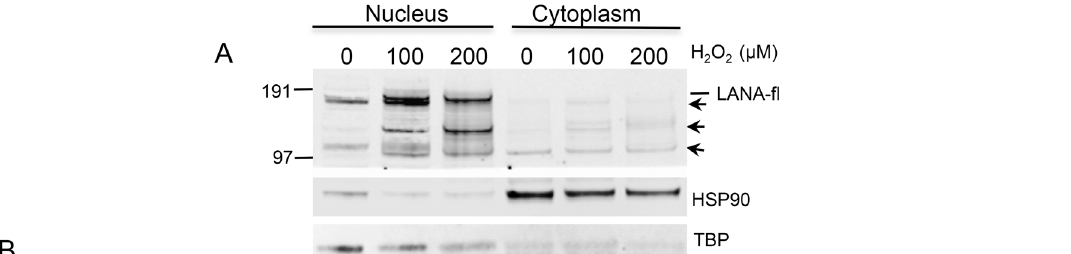
PLOS Pathogens | DOI:10.1371/journal.ppat.1005064 July 28,